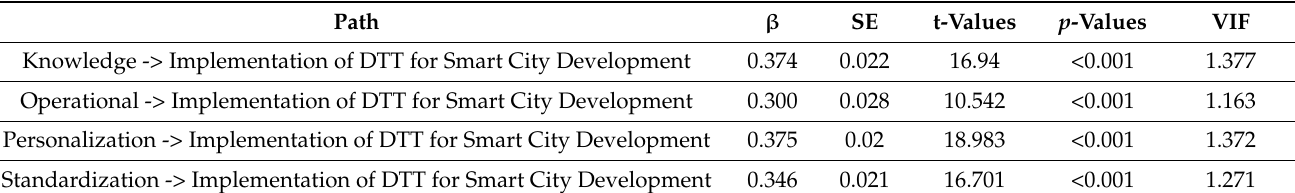
Table 11. SEM path significance